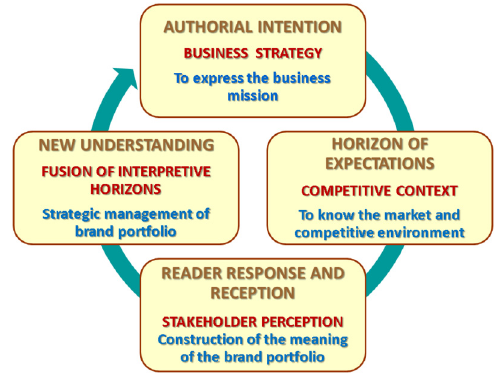
Figure 3. Hermeneutical method for brand identity